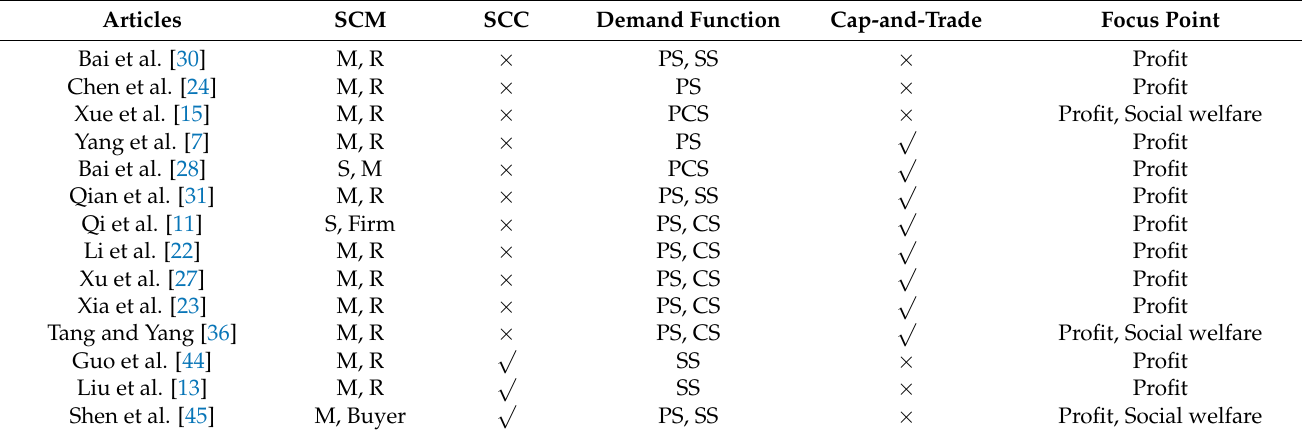
Table 1. Main differences between our works and existing